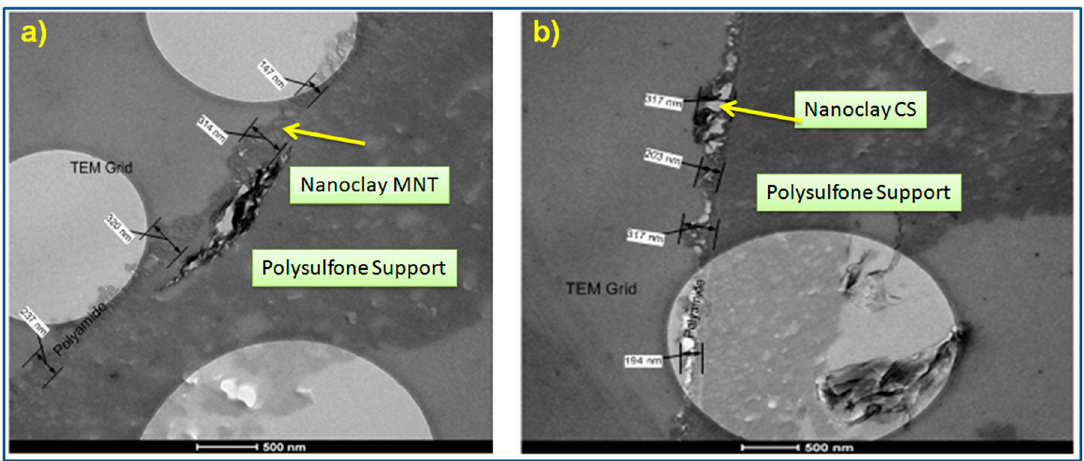
Figure 7. Cross-section transmission electron microscopy image of MNT ( a ) and CS-15A ( b ) modified PA membranes (0.04 wt.% MNT).